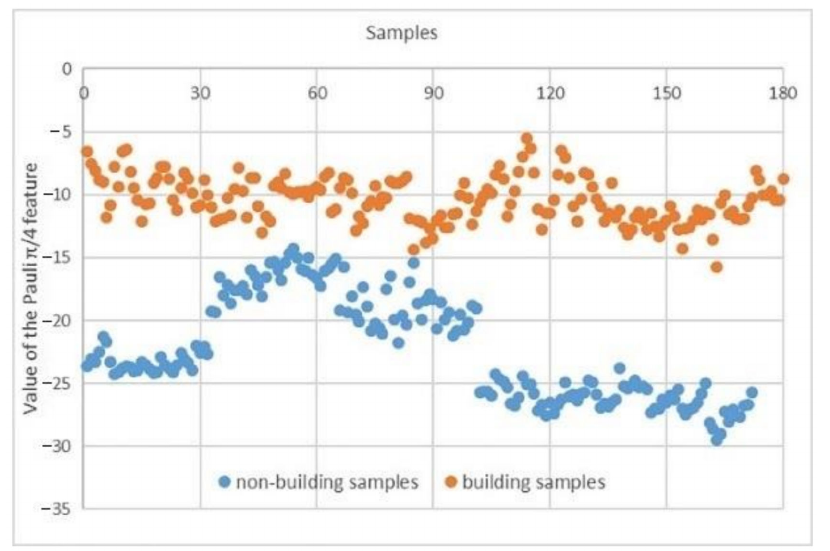
Figure 9. Scatter diagrams of the π /4 double-bounce scattering component of the Pauli decomposition for the non-building samples and built-up area samples in the Yushu study